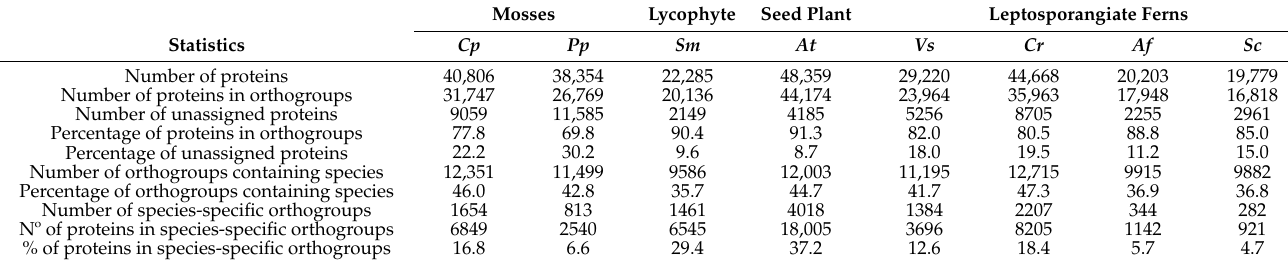
Table 4. Per species statistics of the Orthofinder